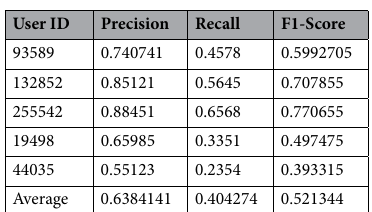
Table 3. Experimentation based on user similarity.